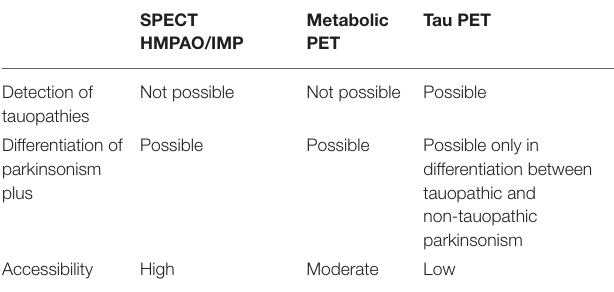
TABLE 2 | Radiotracers – highlighted basic